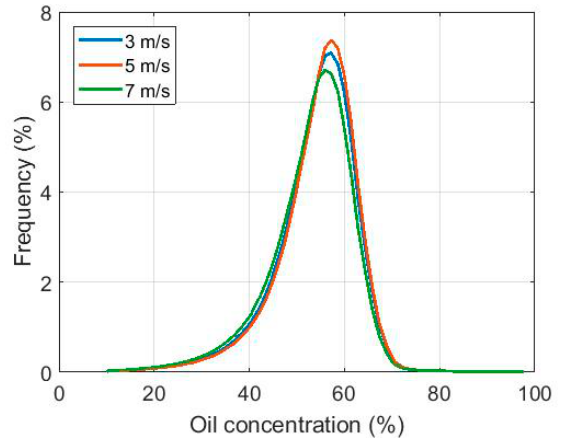
Figure 15. Normalized histograms of oil concentration estimated within the mineral oil slick released during the MOS Sweeper exercise (10:02 UTC) for an input wind speed of 3 m/s (blue), 5 m/s (red) and 7 m/s (green).